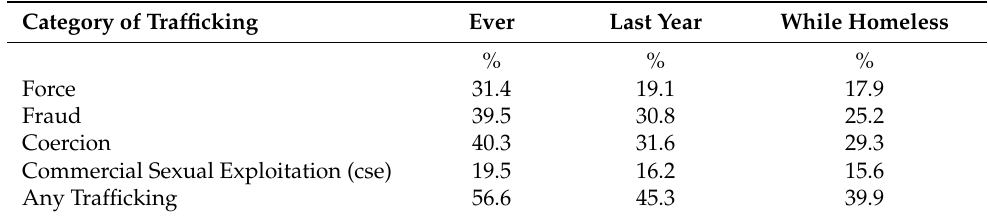
Table 4. Number and percentage of youth who reported each of the four types and any type